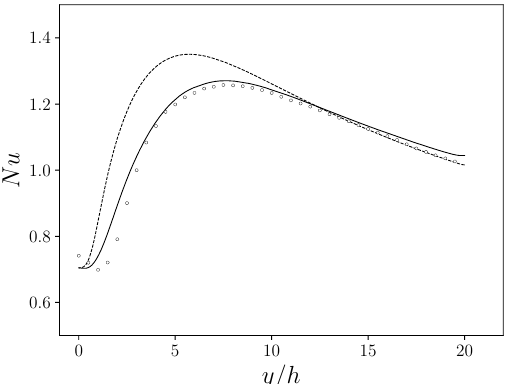
Figure 13. Nusselt number Nu along the heated wall. : Simulation results with the anisotropic four-parameter (A4P) model; : Simulation results with the isotropic four-parameter (4P) model. DNS